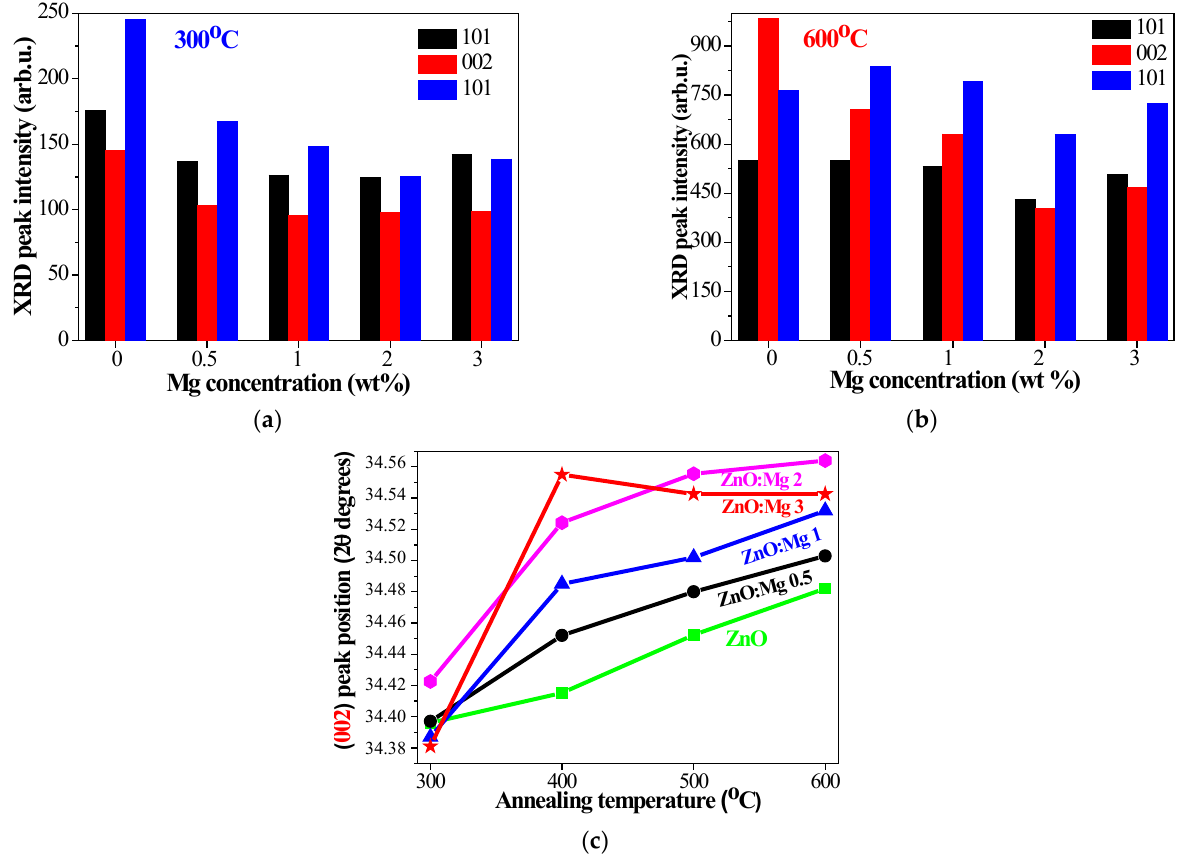
Figure 2. Change of XRD intensities of (100), (002), (101) peaks with Mg concentration, annealed at ( a ) 300 and ( b ) 600 °C. ( c ) Comparison of the diffraction angle shift of the (002) peak of ZnO and ZnO:Mg films, treated at 600 °C.